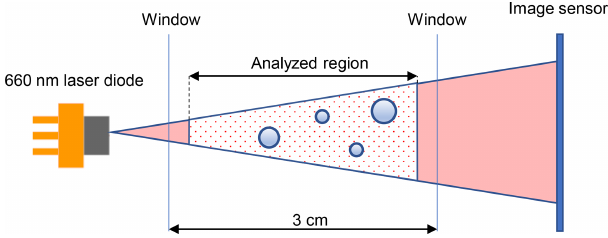
Figure 2. A schematic of the lens-less holographic imaging where the analyzed region is marked as red